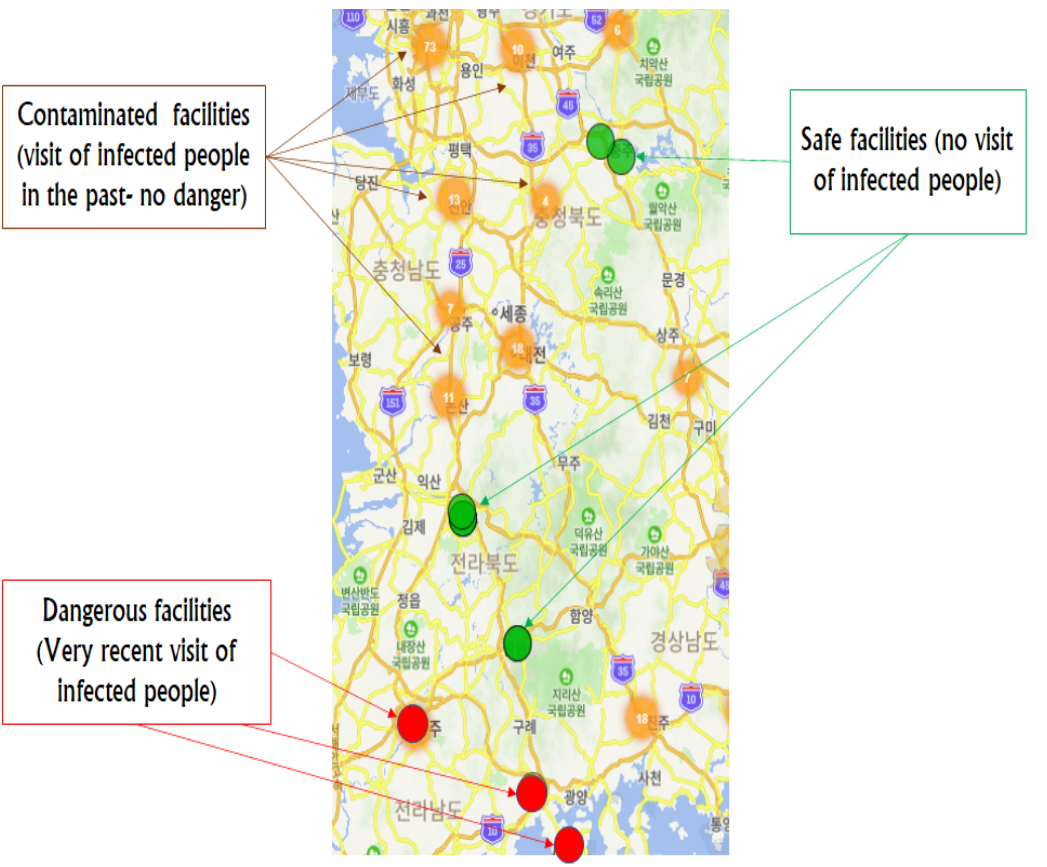
Figure 14. Overview of the safe and risky facilities based on patients’ temporal visit